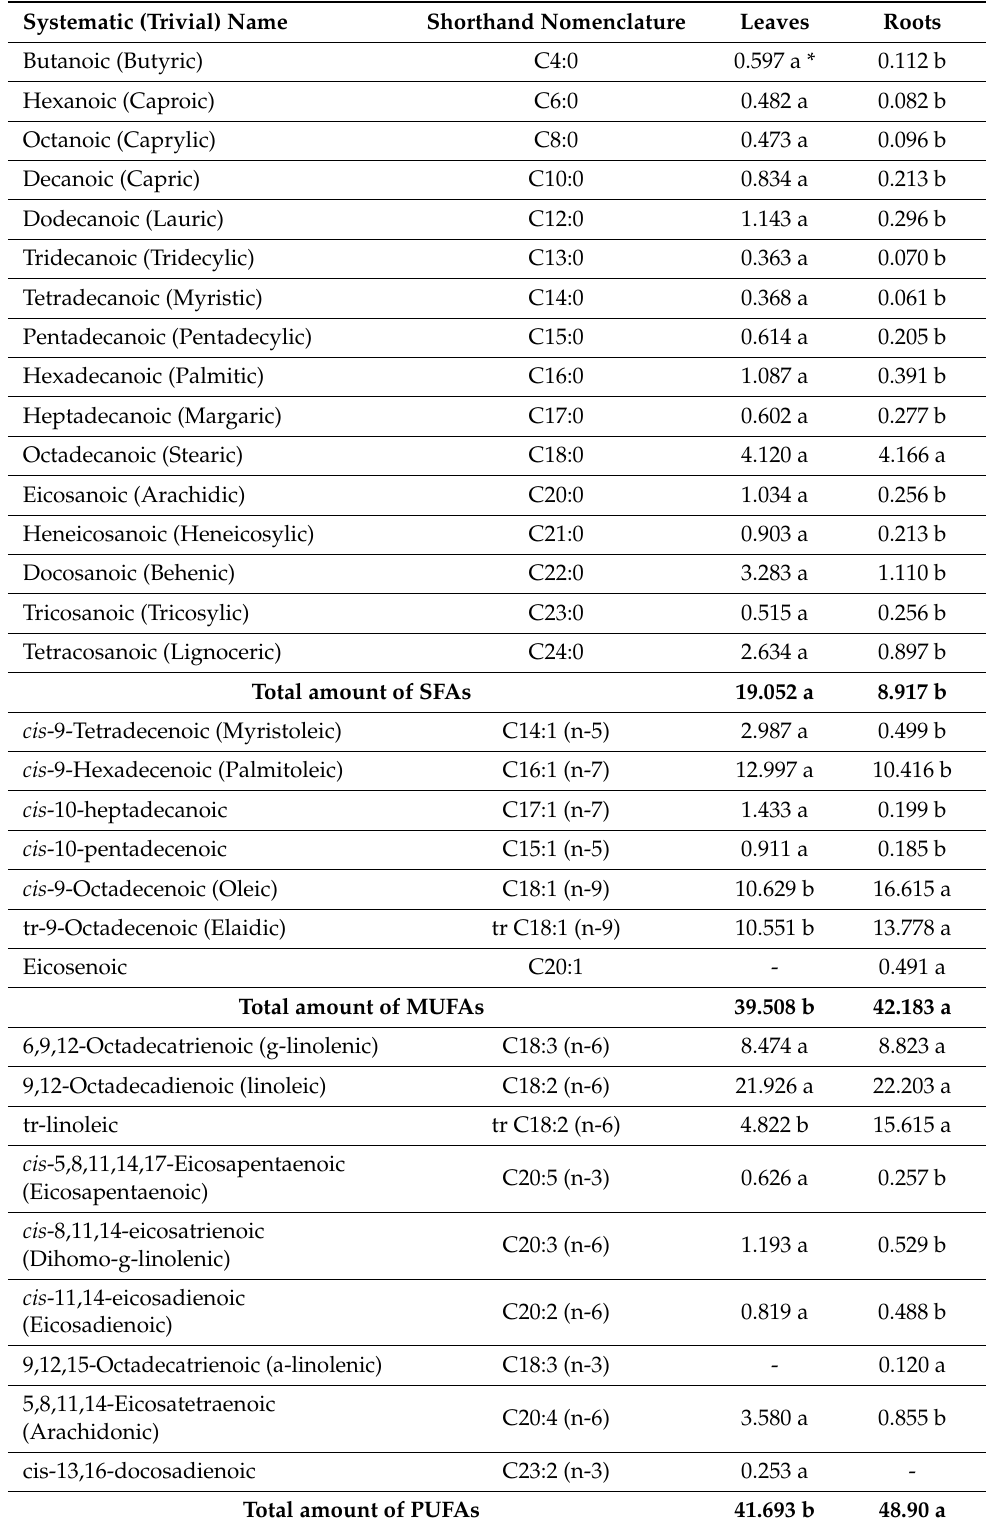
Table 2. Fatty acids profile of stinging nettle ( Urtica dioica L.) leaves and roots, % of all fatty acids